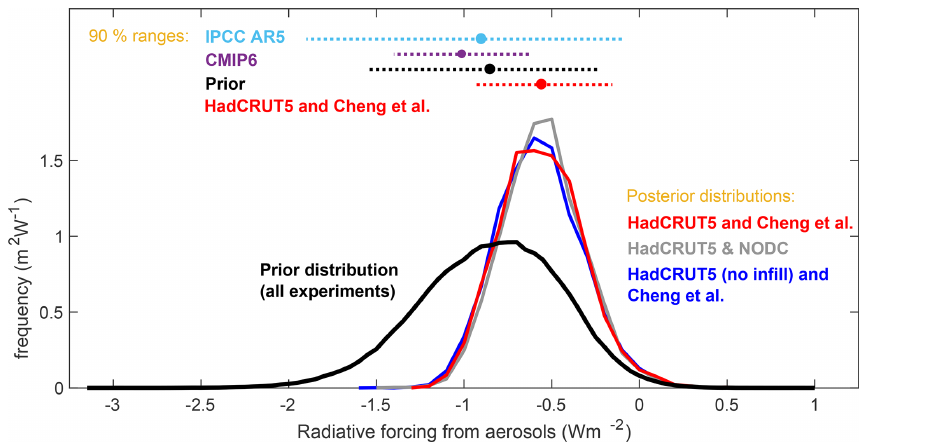
Figure 3. Recent radiative forcing from aerosols in model ensembles and estimates. Solid lines are frequency distributions from the prior model ensembles (black) and posterior model ensembles constrained by different combinations of observational datasets (red, grey, and blue). Also shown are 90% ranges (dotted lines) and best estimates (circles) from IPCC AR5 (IPCC, 2013: light blue), an ensemble of 17 CMIP6 models analysed by Smith et al. (2020) (purple), and the prior and HadCRUT5 and Cheng et al. posterior model ensembles. For model ensembles the best estimate is calculated from the model ensemble mean. The 90% range represents the 5th to 95th percentile in the prior and HadCRUT5 and Cheng et al. model ensembles and represents the mean ± 1.645 standard deviations for the CMIP6 model ensemble. All distributions are for the year 2014, except the IPCC AR5 estimate, which is for the year